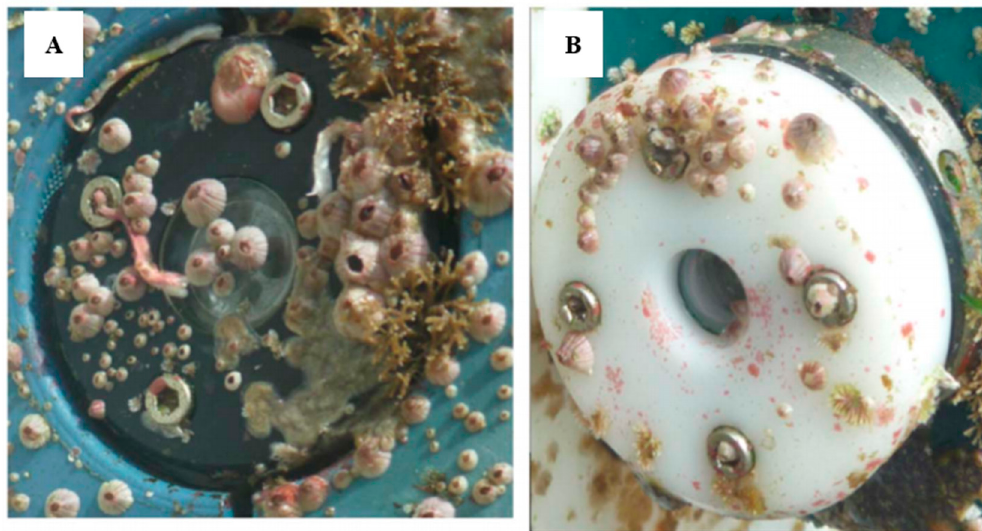
Figure 6. Antifouling system applied to optical sensor submerged in natural seawater for 6 months in France: ( A ) unprotected; ( B ) protected (© 2017 IEEE. Reprinted, with permission, from [98]).